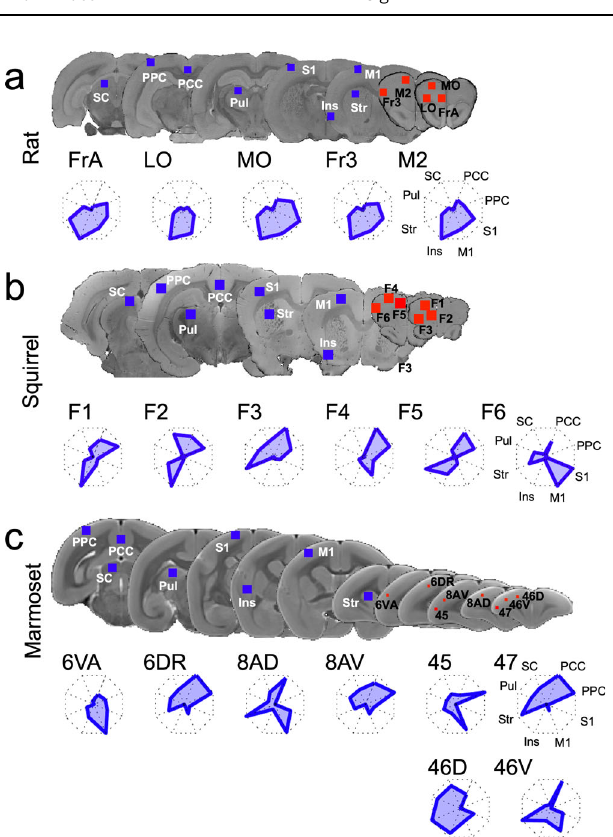
Fig. 2 Region of interest (ROI) locations and fi ngerprint plots. a ROI locations for rats. Top , seed ROIs (all in the right hemisphere) are shown in red, and 8 ROIs for the fi ngerprint analysis are shown in blue and overlaid on coronal slices of anatomical MR images. Bottom , fi ngerprint spider plots for frontal seeds with the posterior cingulate cortex (PCC), posterior parietal cortex (PPC), the primary somatosensory cortex (S1), the primary motor cortex (M1), insular cortex (Ins), striatum (Str), pulvinar (Pul), and superior colliculus (SC). b Same as ( a ), but for squirrels. c Same as ( a ), but for marmosets. Target region abbreviations: Frontal association cortex (FrA); lateral orbital cortex (LO); medial orbital cortex (MO); frontal cortex, area 3 (Fr3); secondary motor cortex (M2); frontal areas 1 – 6 (F1 – F6); area 6 of cortex, ventral, part a (6 VA); area 6 of cortex, dorsorostral part (6DR); area 8a or cortex, dorsal part (8AD); area 8a of cortex, ventral part (8AV); area 45 of cortex; 46 area 47 of cortex; 48 area 46 of cortex, dorsal part (46D); area 46 of cortex, ventral part (46 frontal regions in squirrels and lateral frontal areas in marmosets. Many comparisons were still signi fi cantly different between the two species (29/48; p < 0.05). The largest similarities were found between squirrel areas F3 – F6 with lateral prefrontal marmoset areas. This fi nding shows that the squirrel frontoparietal cortex FC fi ngerprints resemble those of lateral prefrontal cortical areas in the marmoset.